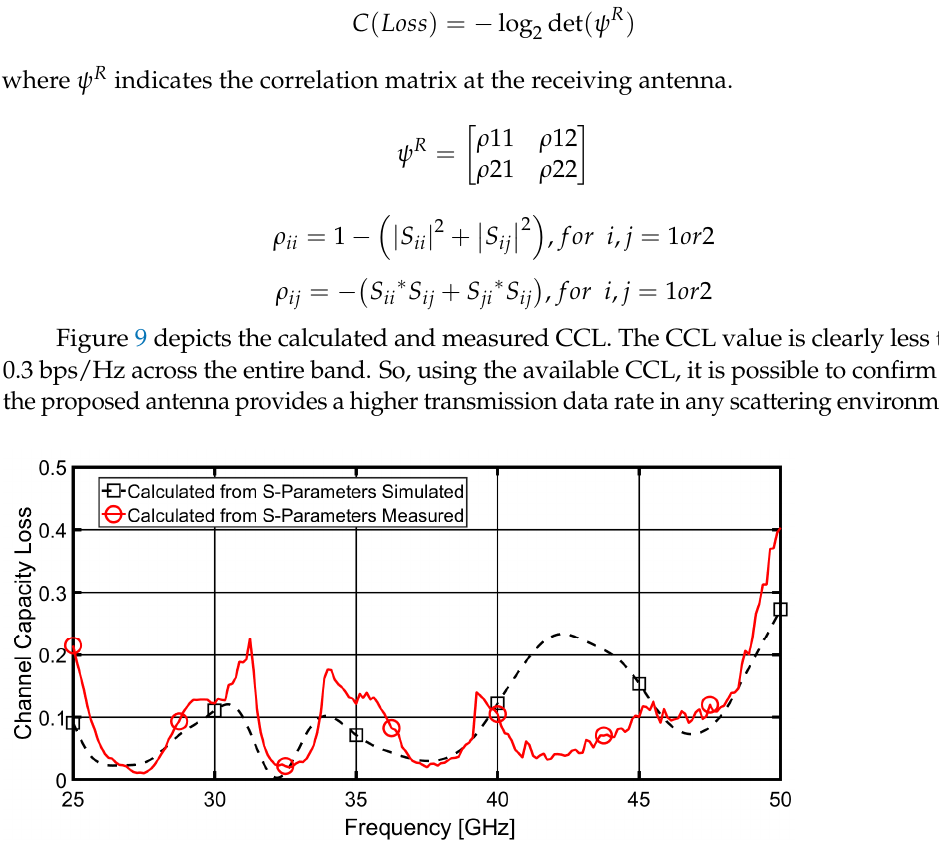
Figure 9. CCL of the proposed four-element MIMO antenna between port 1 and 2.